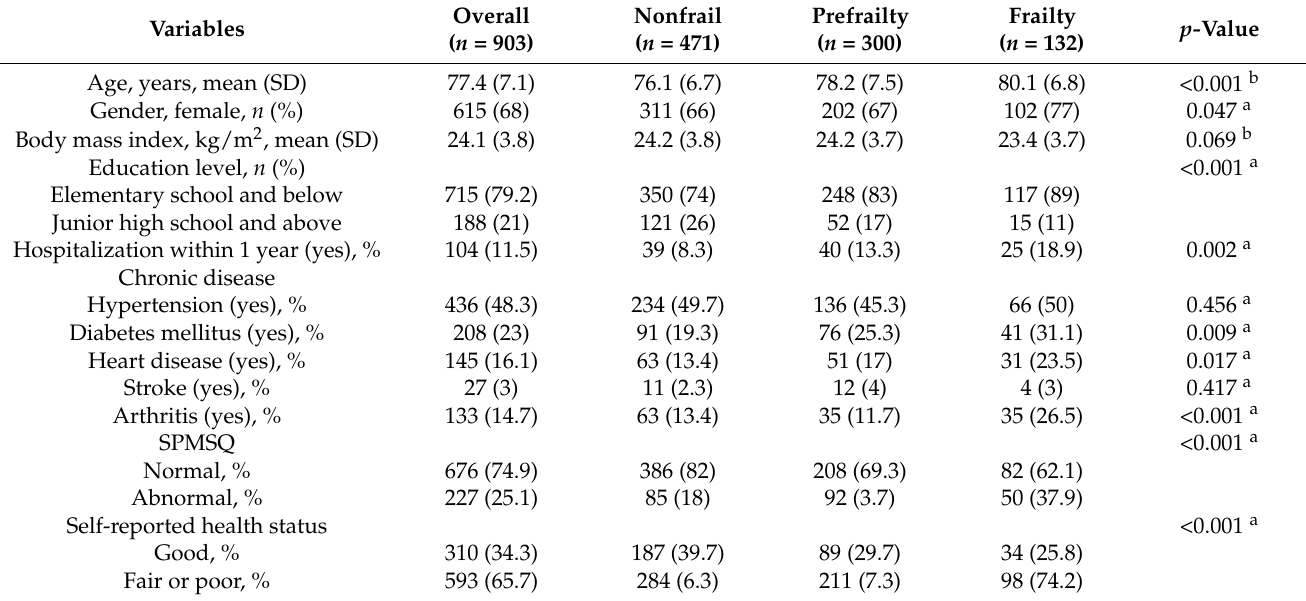
Table 1. Characteristics of the study